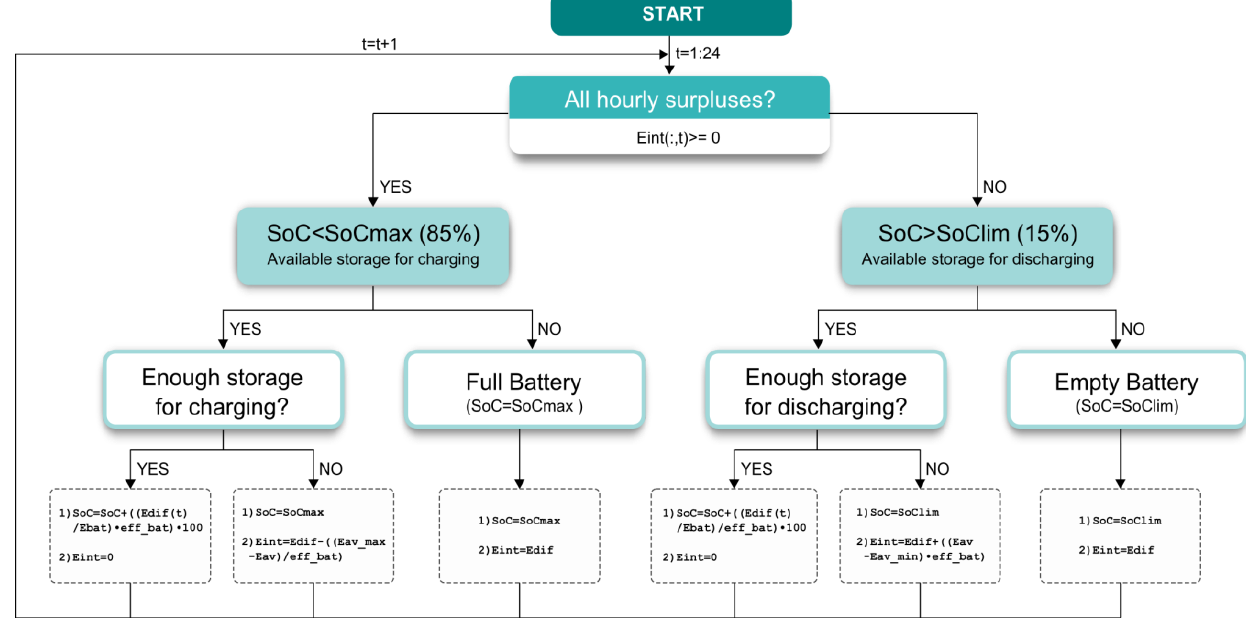
Figure 2. Home- level algorithm’s diagram flux. Figure 2. Home-level algorithm’s diagram